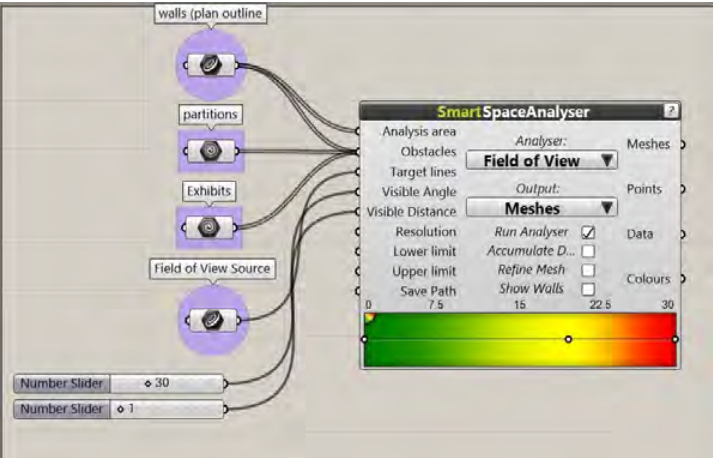
Figure 1. Field of view Component (Smart space analyzer)